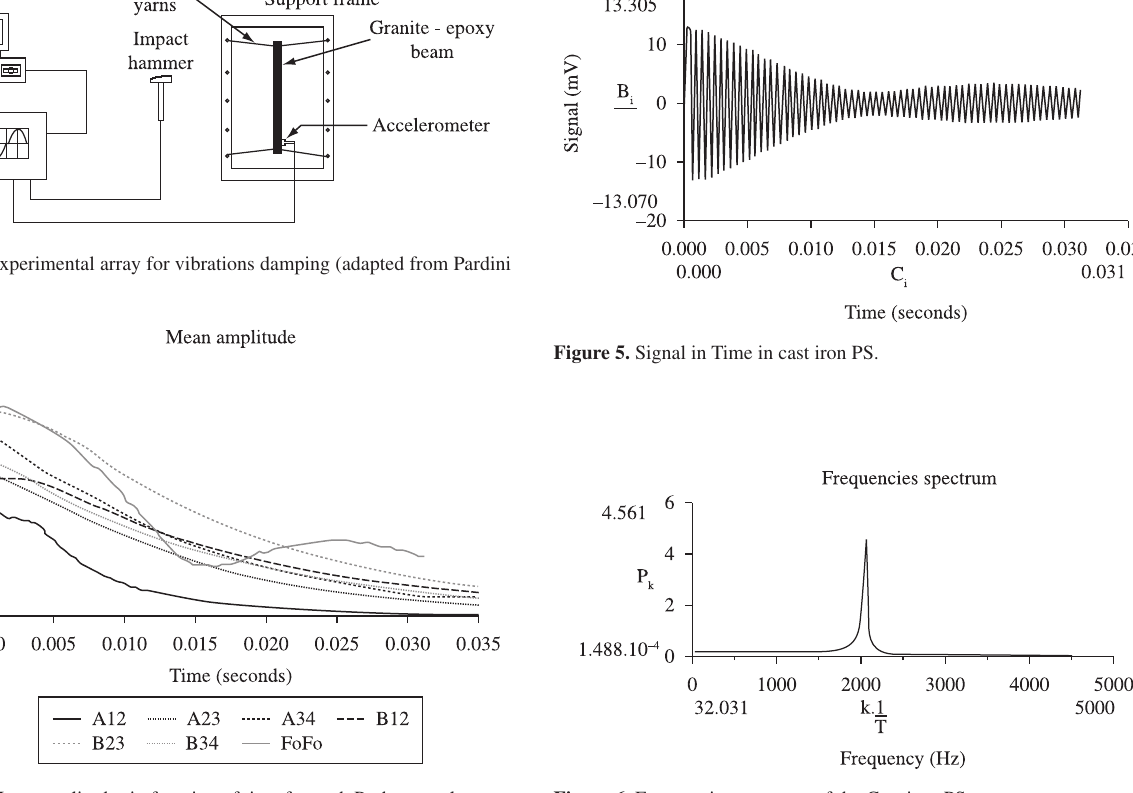
Figure 6. Frequencies spectrum of the Cast iron PS